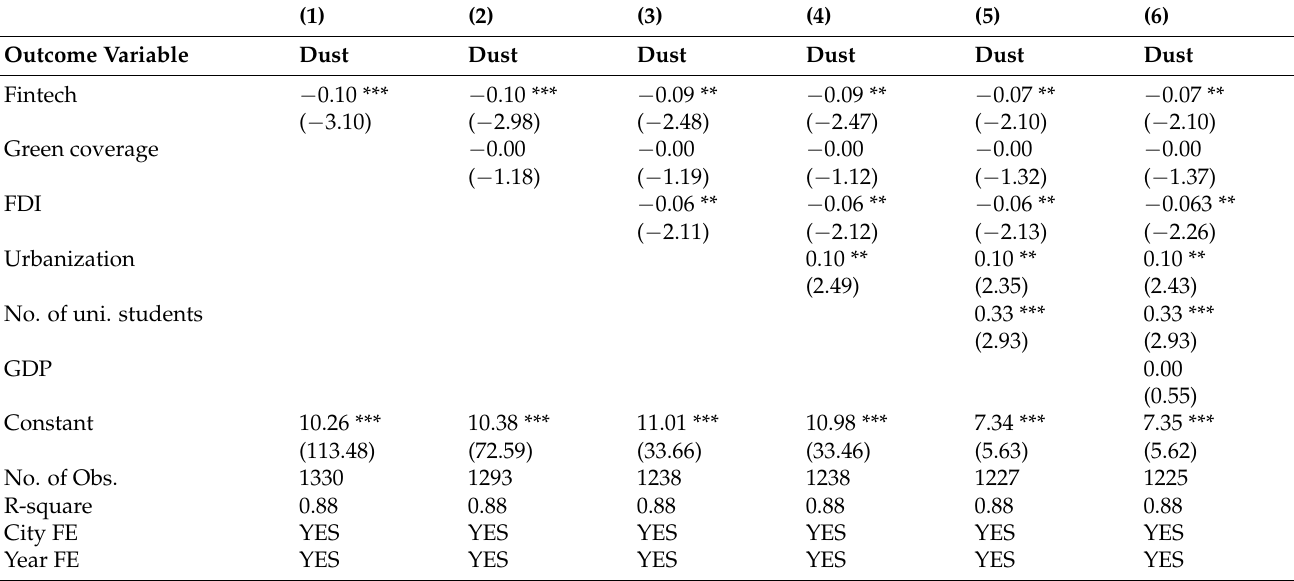
Table 4. Stepwise regression results table of